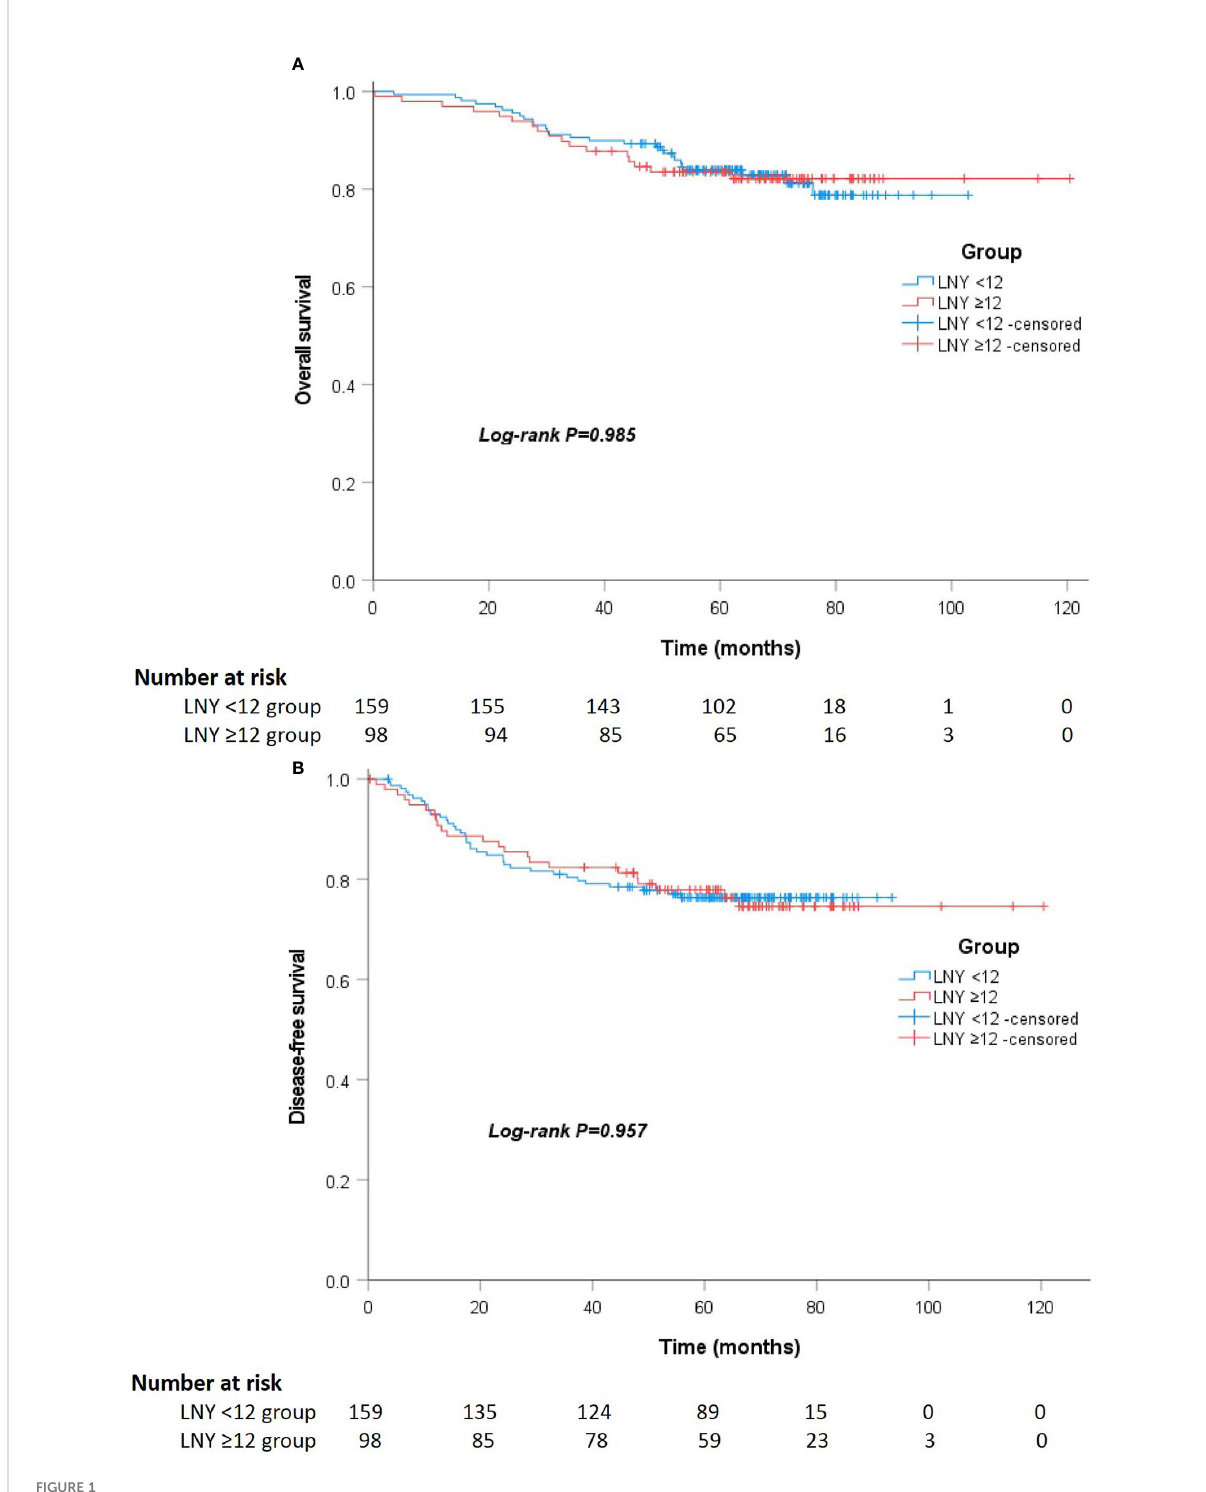
FIGURE 1 (A) Kaplan-Meier curves showing the overall survival strati fi ed by LNY ≥ 12 and LNY <12 groups in the total cohort (P=0.985). (B) Kaplan-Meier curves showing the disease-free survival strati fi ed by LNY ≥ 12 and LNY <12 groups in the total cohort